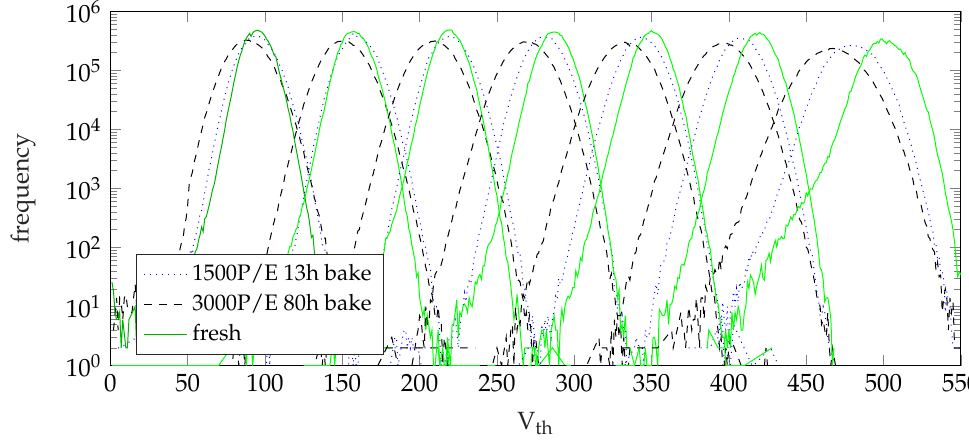
Figure 1. Model of the voltage distribution of a TLC flash memory with labeled reference threshold voltages (dashed lines) and bit labeling.